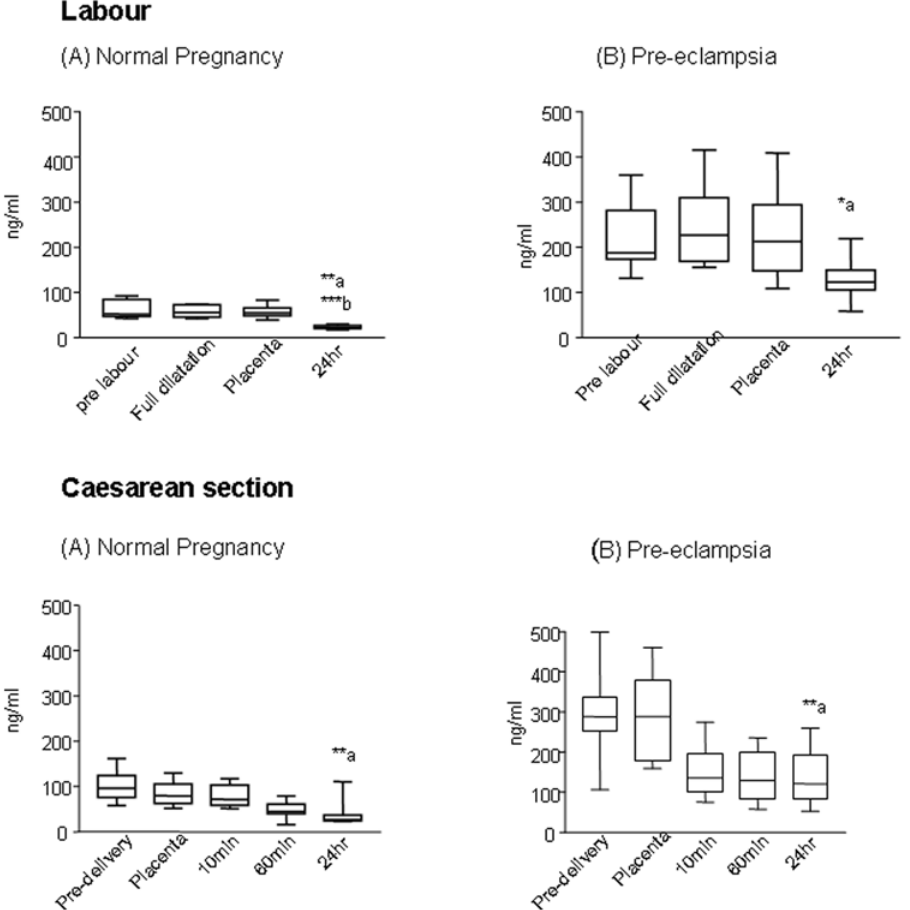
Figure 4. sEndoglin levels in maternal plasma during labour (A, B) and Caesarean section (C,D). Median and ranges for sEndoglin ng/ml. In normal pregnancy labour (A) the levels declined by 24 hr (a***p , 0.001, pre-labour vs 24 hr, b**p , 0.01-full dilatation vs 24 hr, and placental delivery vs 24 hr). In pre-eclampsia labour (B) a similar decline by 24 h was noted (a*p , 0.05, pre-labour vs 24 hr, full dilatation vs 24 hr, and placental delivery vs 24 hr). At Caesarean section (C,D) a significant decline in levels of sEndoglin by 24 hr was noted with placental delivery in both normal pregnancy and pre-eclampsia (a**p , 0.01).